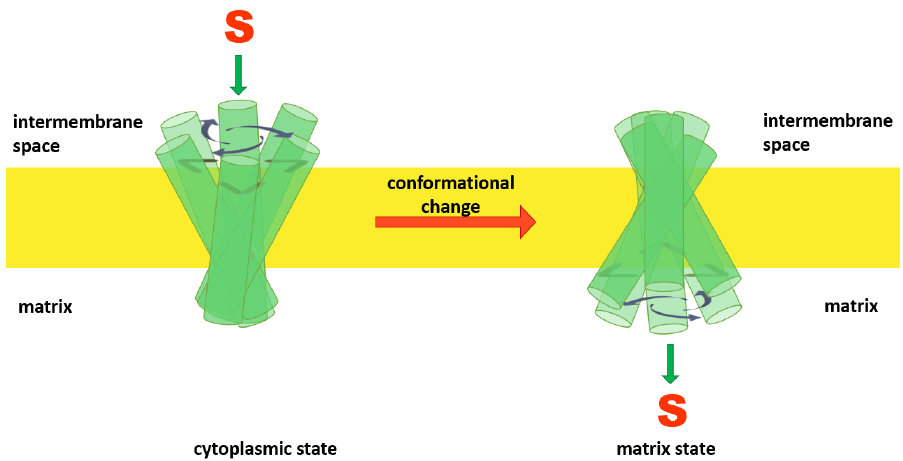
Figure 2. Alternating access mechanism is proposed to be a common mechanism for substrate translocation by members of the MCF. In this model the protein’s cavity opens alternately towards the cytoplasmic and matrix sides alternatively.